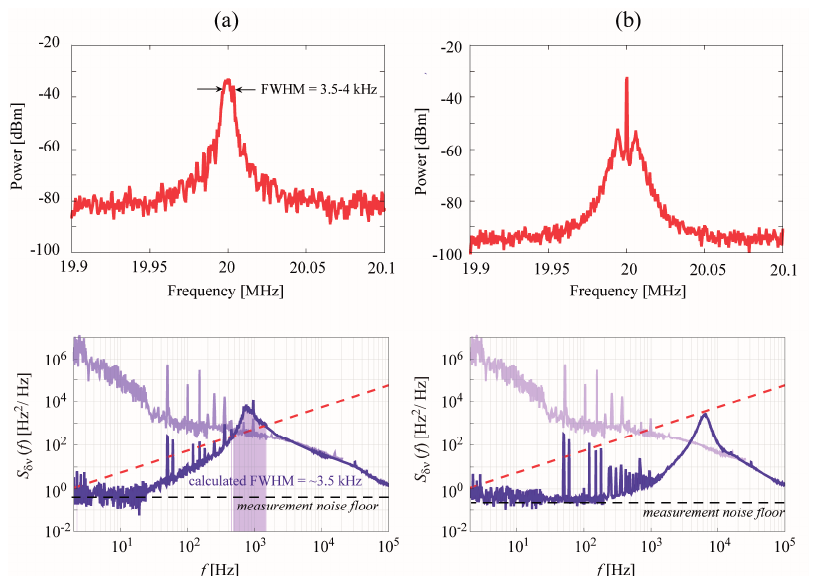
Figure 5. ( a ) Loose lock and ( b ) tight lock achieved for the CEO beat in an Er:Yb:glass DPSSL comb [27,28]. The upper graphs show the RF spectrum with the presence of a coherent carrier in the case of the tight lock. The lower graphs show the corresponding frequency noise PSD for the free-running (grey curves) and stabilized (blue curves) CEO beat. The linewidth of the locked CEO beat can be approximated using the β -separation line introduced by Di Domenico et al. [47] (dashed red line). In the case of a loose lock ( a ), a finite linewidth is obtained that is proportional to the colored area for which the frequency noise PSD exceeds the β -separation line. For a tight lock ( b ), the frequency noise PSD is completely reduced below the β -separation line, which corresponds to a FWHM linewidth reduced to zero that is representative of the presence of a coherent